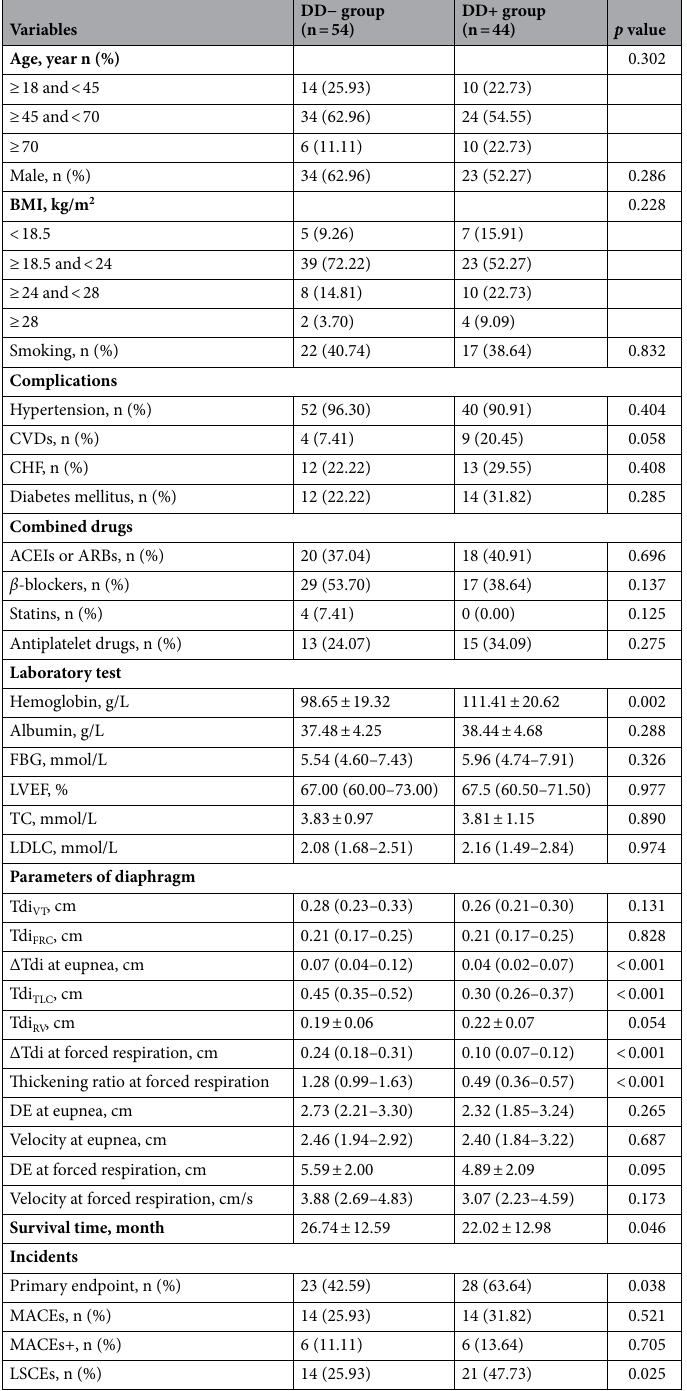
Table 1. The baseline clinical characteristics and incidents of all participants according to the diaphragm function. BMI, body mass index; CVDs, cardiovascular diseases; CHF, chronic heart failure; FBG, fasting blood glucose; LVEF, left ventricular ejection fraction; TC, total cholesterol; LDLC, low density lipoprotein cholesterol; ACEIs, angiotensin converting enzyme inhibitors; ARBs, angiotensin receptor blockers; DE, diaphragm excursion; MACEs, major adverse CV events; MACEs+, other major adverse CV events; LSCEs, less serious CV events; ΔTdi at eupnea, Tdi VT − Tdi FRC ; ΔTdi at force respiration, Tdi TLC − Tdi RV ; thickening ratio at forced respiration, (Tdi TLC − Tdi RV ) ∕ Tdi RV